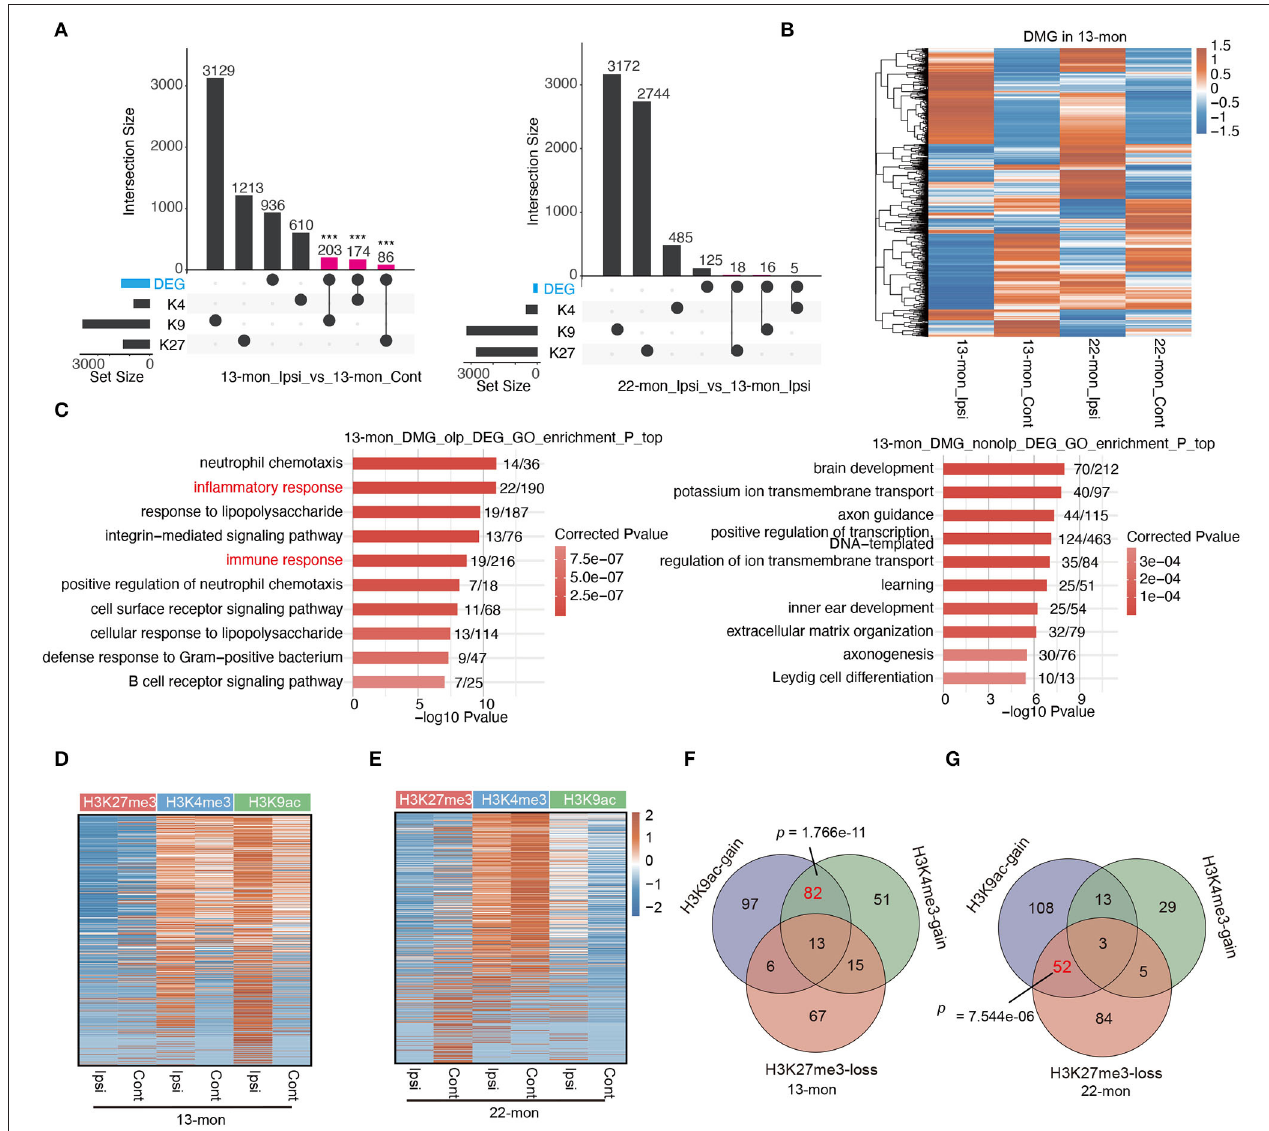
FIGURE 5 | pDMGs significantly overlap with DEGs. (A) Upset bar plot shows the overlapped gene number among DEGs and three histone-modified genes in 13-month-old (left) and 22-month-old (right) Ipsi rats. (B) Hierarchical clustering heat map shows the expression level of genes that are differentially modified by histone marks in 13-month-old Ipsi rats. (C) Bar plot shows the top 10 enriched GO BP terms of DEGs that overlap with DMGs (left) or do not overlap with DMGs (right) in 13-month-old ICH rats. (D) Heatmap of the three histone marker signals at the TSS regions in 13-month-old rats for co-upregulated DEGs. The genes were ranked according to average fold enrichment using the MACS2 software. (E) Heatmap of the three histone marker signals at the TSS regions in 22-month-old rats for co-upregulated DEGs. The genes were ranked according to average fold enrichment using the MACS2 software. (F) Venn diagram shows the overlapping upregulated DEGs that are specifically enriched with H3K9ac, H3K4me3 markers, or shows the loss of H3K27me3 marker in 13-month-old ICH rats. (G) Venn diagram shows the overlapping upregulated DEGs that are specifically enriched with H3K9ac, H3K4me3 markers, or shows the loss of H3K27me3 marker in 22-month-old ICH rats. P -value was determined by using the Student’s t-test. *** p <